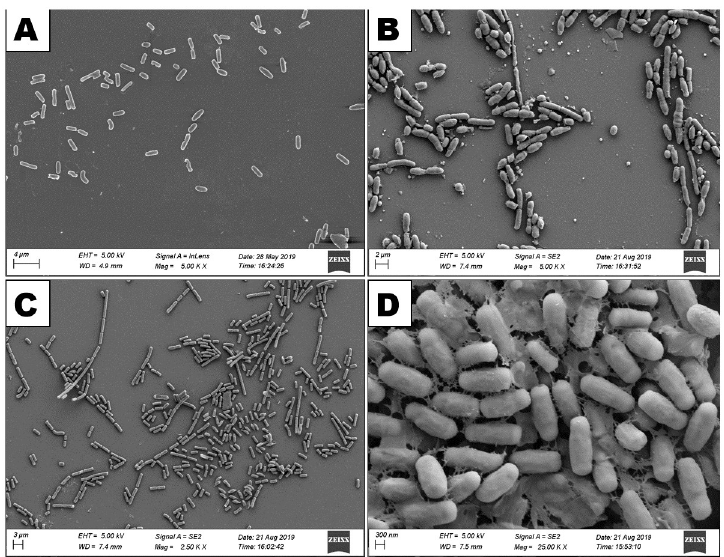
Fig 13. Scanning electron micrograph showing endospores of the bacterial isolates. A: Bacillus cereus HABW1, B: Bacillus megaterium HABW4, C: Bacillus subtilis HABW10, D: Bacillus tequilensis HABW14.